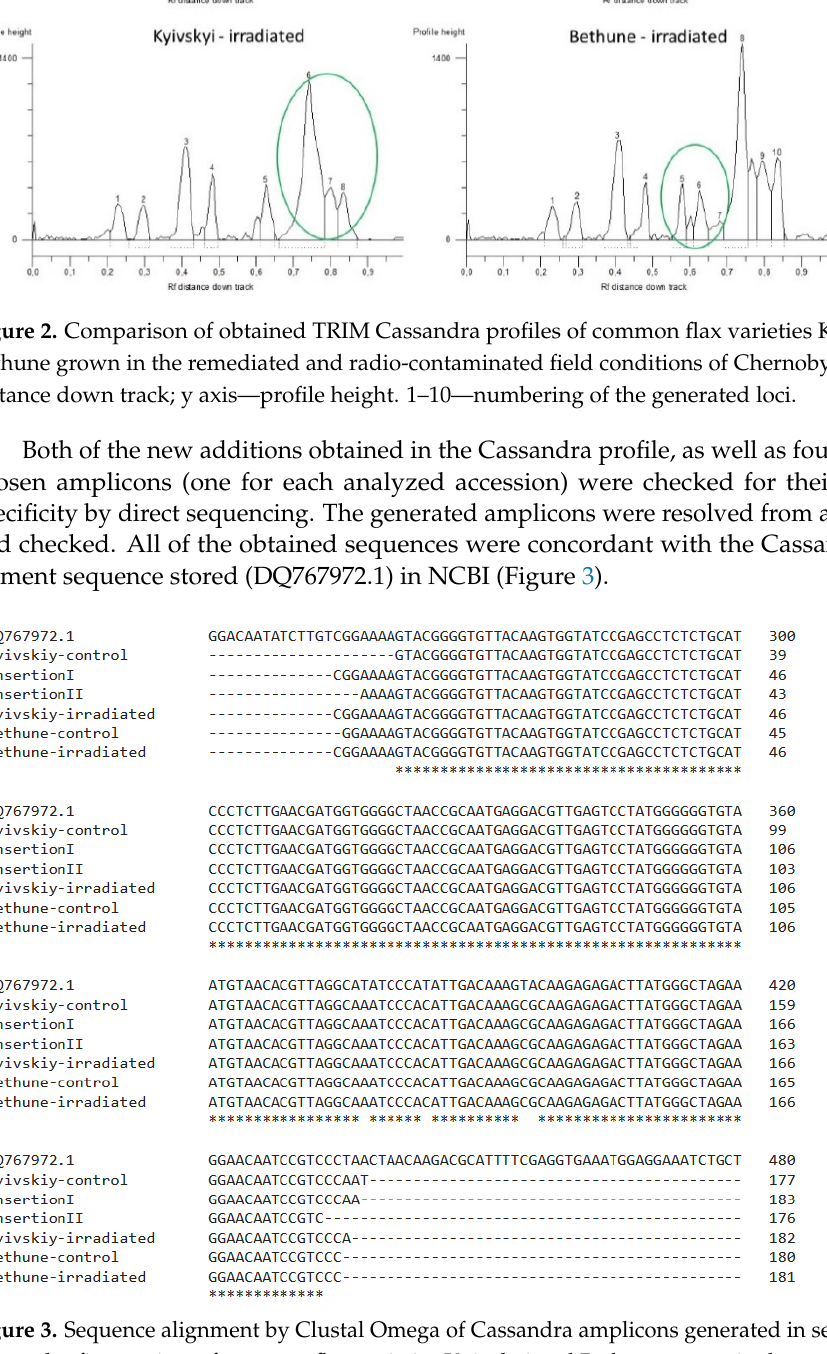
Figure 4. Restriction digestion of sequenced selected TRIM Cassandra fingerprints of common flax varieties Kyivskyi and Bethune grown in the remediated and radio-contaminated field conditions of Chernobyl. L—ladder (100 bp; Thermo Scientific); K-C: Kyivskyi control; K-I: Kyivskyi irradiated; B-C: Bethune control; B-I: Bethune irradiated; iI—inserted amplicon I; iII—inserted amplicon II; NRS—no restriction sample. A 1000 bp ladder was used (Fermentas). For the dLUTE transposon fingerprints, a total of 18 amplicons were generated for the Kyivskyi flax variety and 19 amplicons for the Bethune variety. The length of the obtained amplicons varied from 230 bp up to the 2090 bp for the Kyivskyi and from 220 bp up to the 2090 bp for the Bethune variety. The dLUTE profile that was obtained